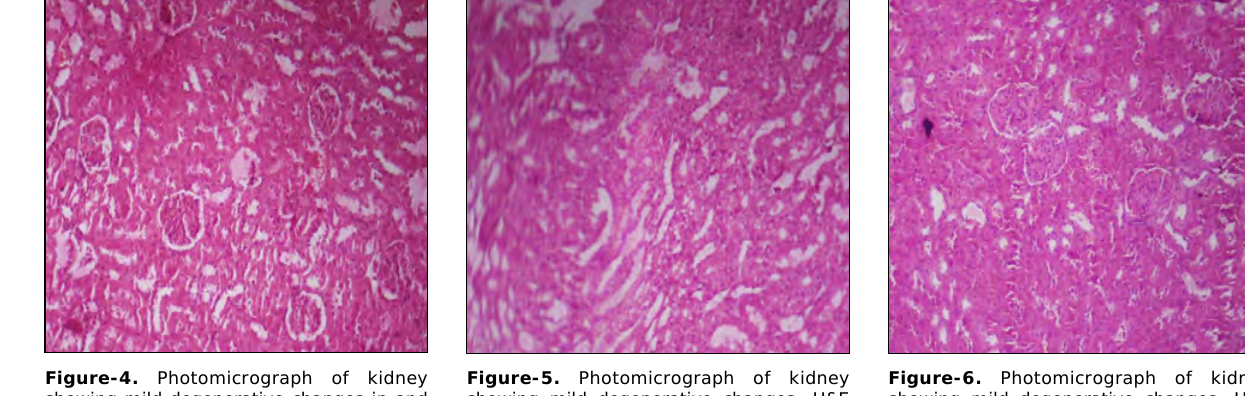
Figure-4. Photomicrograph of kidney showing mild degenerative changes in and around glomeruli. H&E X200 (Group 6)